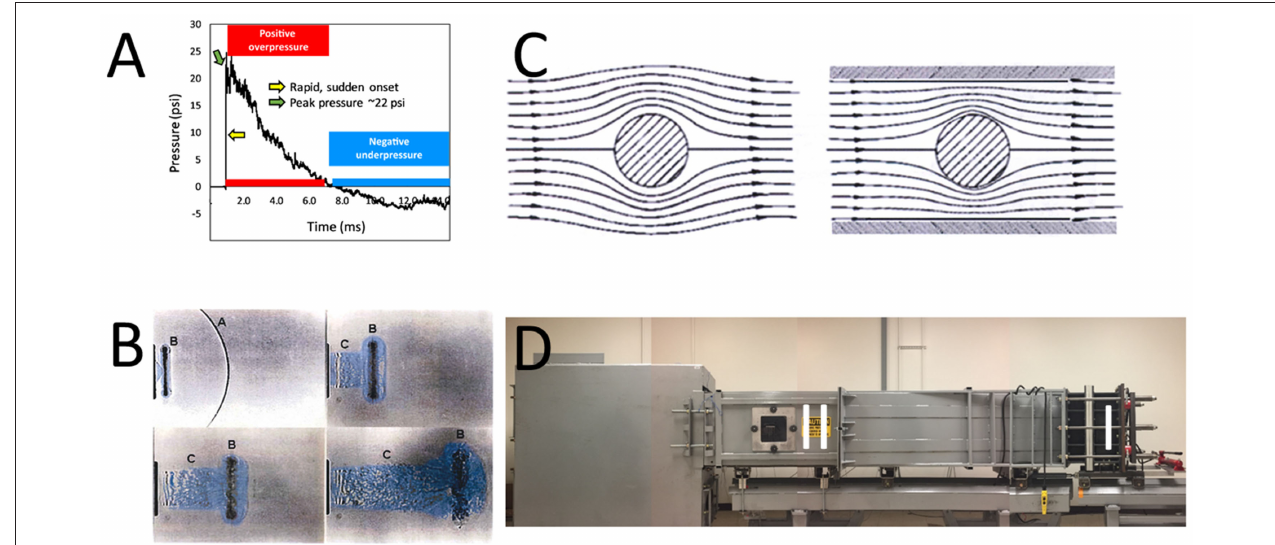
FIGURE 1 | Illustrations for implementation of shock tubes. (A) An example of a Friedlander-type shock wave initiated in an ABS. The tube has been previously described ( 205), and in this setting, a Valmex (7270, Low & Bonar, Martinsville, VA) membrane was employed to generate a shock wave of ∼ 22 psi “peak pressure” (green arrow). The time-pressure trace shows the almost instantaneous change (yellow arrow) in ambient pressure from the shock wavefront, as well as the positive phase (red horizontal bar) and negative phase (blue horizontal bar) that follows as “blast wind.” (B) An example of the complex end-jet waveform. The shock wave [A in upper left of photo in (B) ] emerges from the end of the shock tube and quickly diffracts into a curved front. Following [B in (B) ] is a “ring vortex” and [C in (B) ] a venting jet which has a different waveform than the static pressure phase of a Friedlander waveform [from (198)]. (C) Illustration of the flow field of a shock wave as it diffracts around a test object. Larger test objects in a confined shock tube can alter the flow of the shock wave, distorting free-field conditions [From ( 198). (D) Photograph of the ABS at the Uniformed Services University of the Health Sciences [cf., ( 205)]. The illustration depicts several aspects of optimal design of a shock tube. The driver section (I) is distal to the position of the test section (II), where, e.g., an animal would be secured for study. Likewise, the position of the animal is distal to the end of the tube, obviating end-jet effects (including reflected waves) resulting from the emergence of the shock wave from the